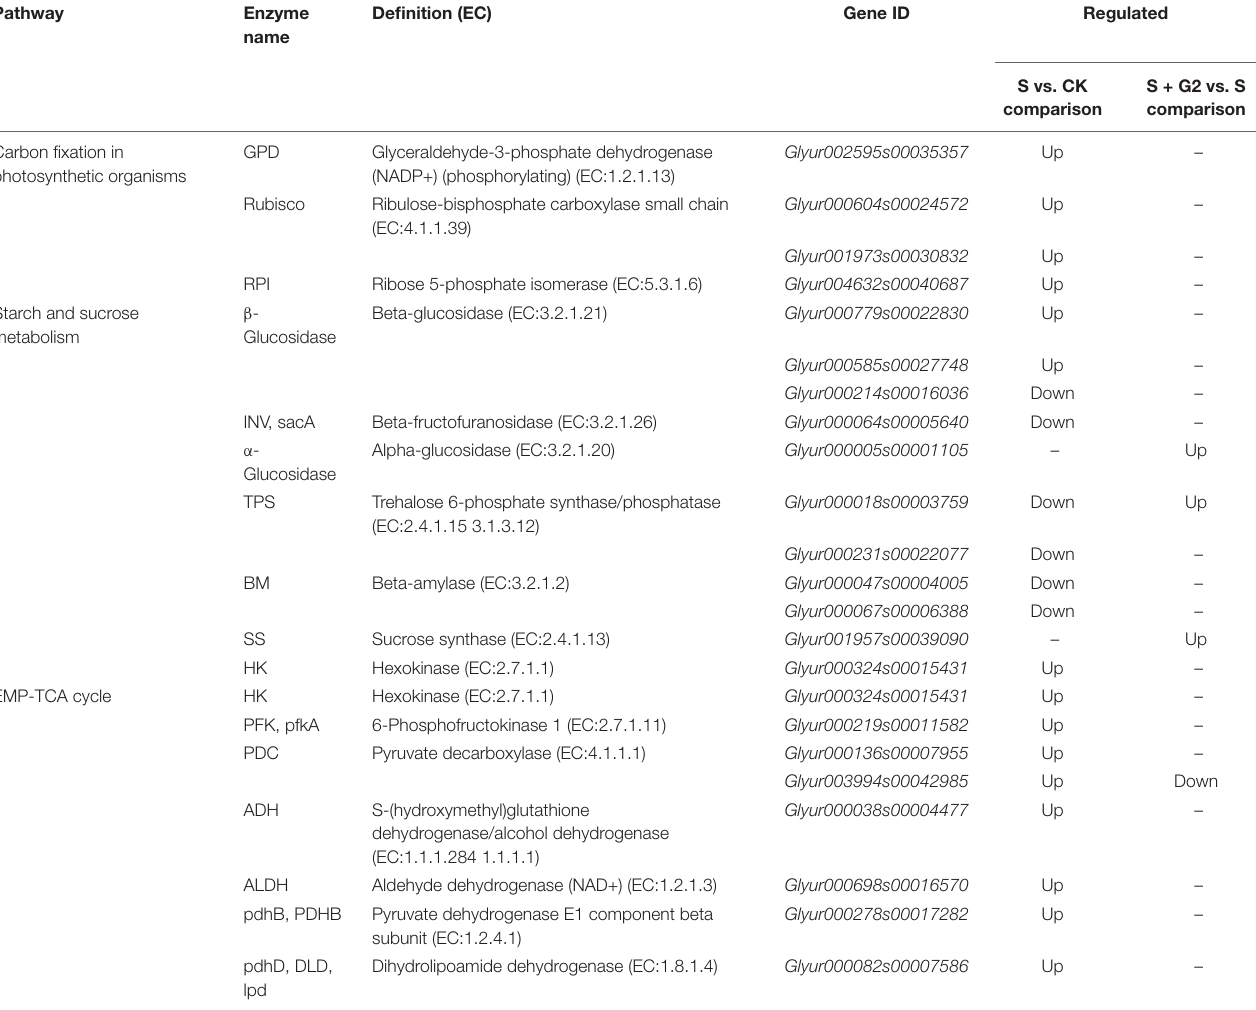
TABLE 1 | Regulation of carbohydrate metabolism-related DEGs in G. uralensis by salt stress or B. cereus G2. Pathway